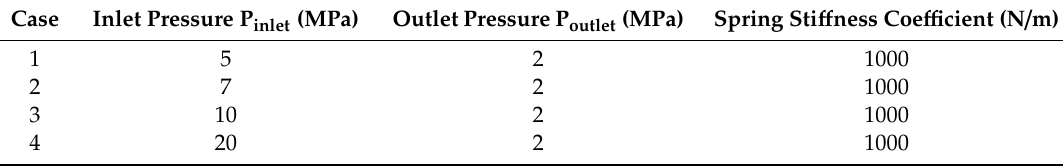
Table 1. Parameter details of the cases.